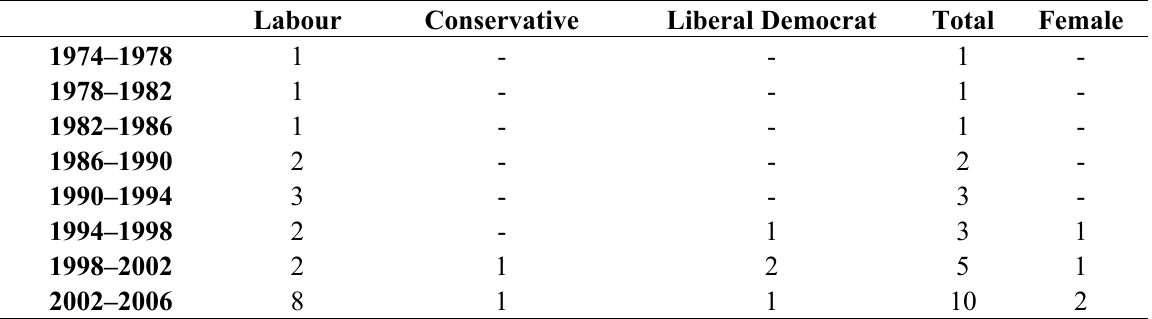
Table 6. Party Breakdown of Muslim Councilors in Hackney, 1974–2010.